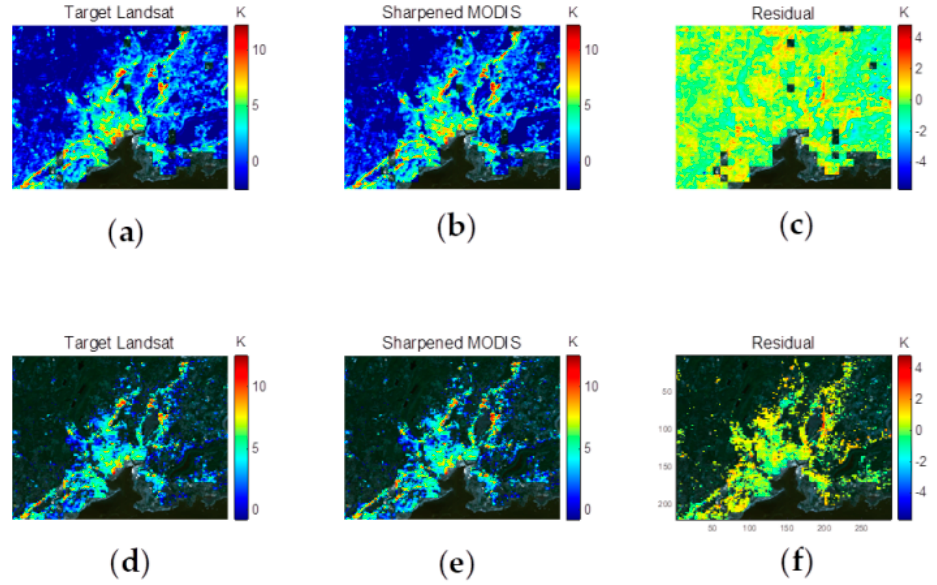
Figure 13. Sharpening LST map for 22 September 2016. ( a , b ) are the target Landsat LST and the sharpened MODIS LST for the entire scene, and ( d , e ) are for urban areas only. ( c , f ) are